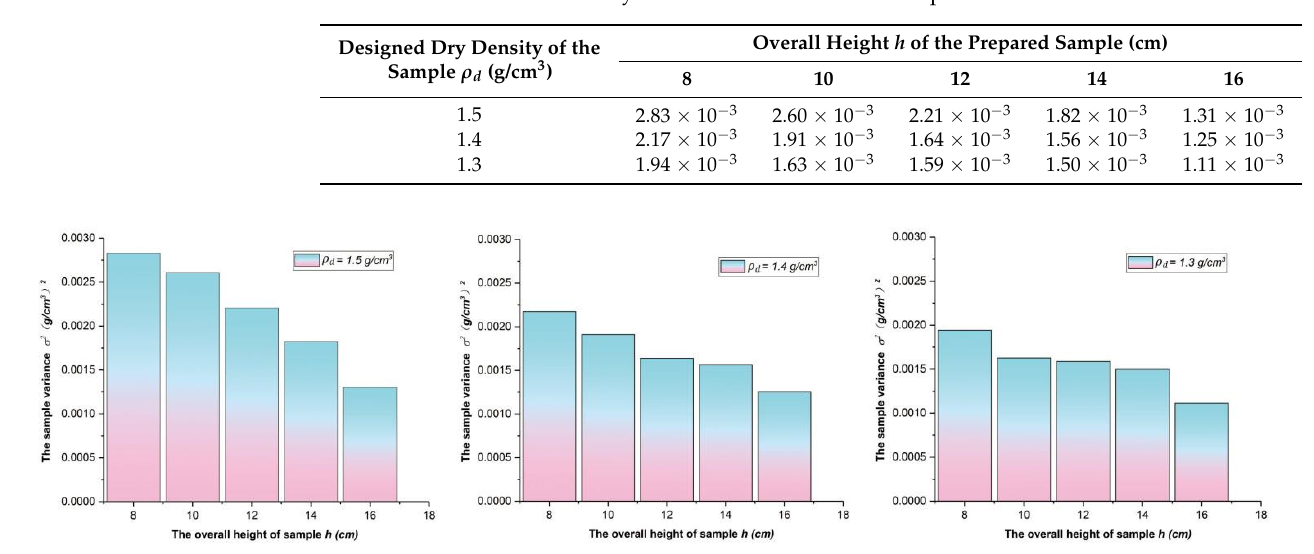
Table 3. The variance in the dry densities of the stratified samples.